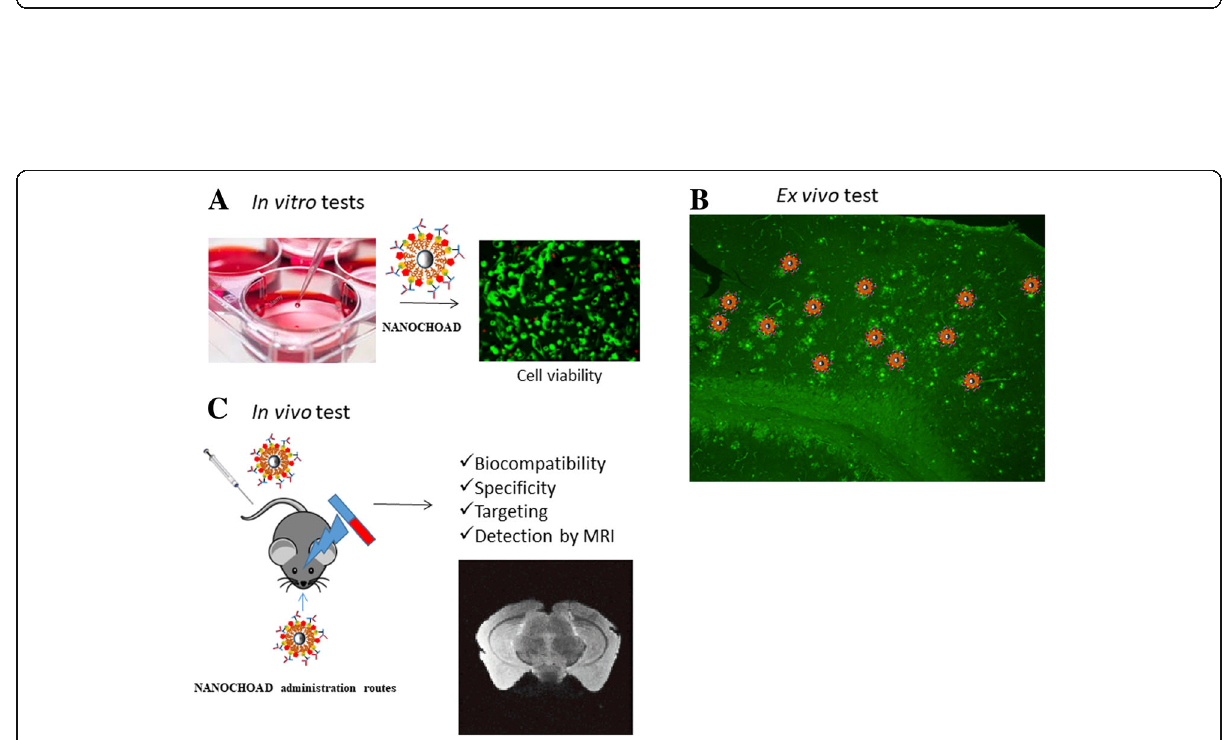
Fig. 1 Schematic diagram of the designed nanoplatform and its mechanism of action. a the structure of MNP, and functionalization with anti-CHO antibody (NANOCHOAD), b strategies for penetration of the nanoplatform through BBB, c Crossing mechanism through the BBB of NANOCHOAD. d nanoconjugate anti-CHO-MNP targeting CHO deposits on amyloid plaques